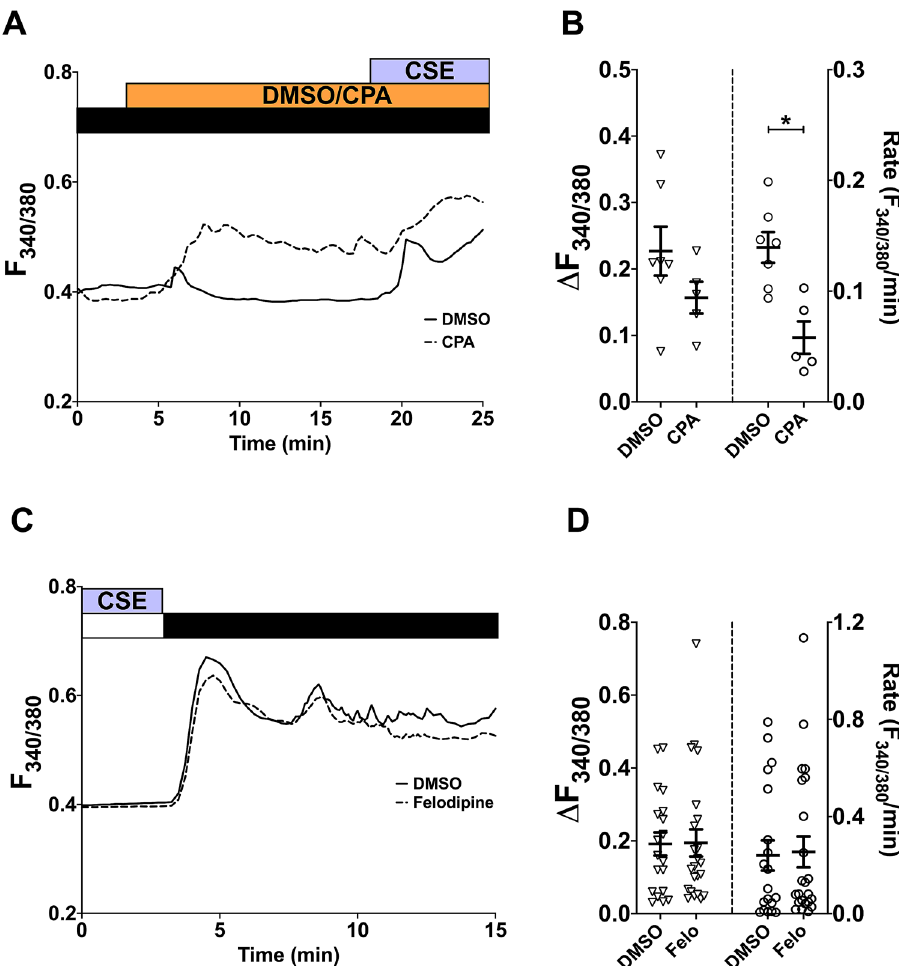
Figure 4. CSE-induced Ca 2+ influx also utilises a different pathway from SOCC and LTCC. (A,C) Representative Ca 2+ imaging traces from separate experiments tracking changes in [Ca 2+ ] i following perfusion with 10% CSE after 15-min treatment with 10 µM CPA (A) , or following Ca 2+ addback (1 mM Ca 2+ ; black bar) after 5-min perfusion with 10% CSE in a nominally Ca 2+ -free solution (white bar), with or without 10-min pre-treatment with 1 µM felodipine, which was also present throughout the experiment (C) . Equal volumes of DMSO (0.01% for CPA, 0.001% for felodipine) were used for vehicle control. (B,D) Summary of amplitude and rate of CSE-induced or Ca 2+ addback [Ca 2+ ] i changes corresponding to experiments in (A,C) , respectively, presented as mean ± SEM. Unpaired t-test was performed between the CPA-treated group ( B ; 2 independent donors; n = 5–7) or felodipine-treated group ( D ; 4 independent donors; n = 19–23) against the vehicle control group. *p <